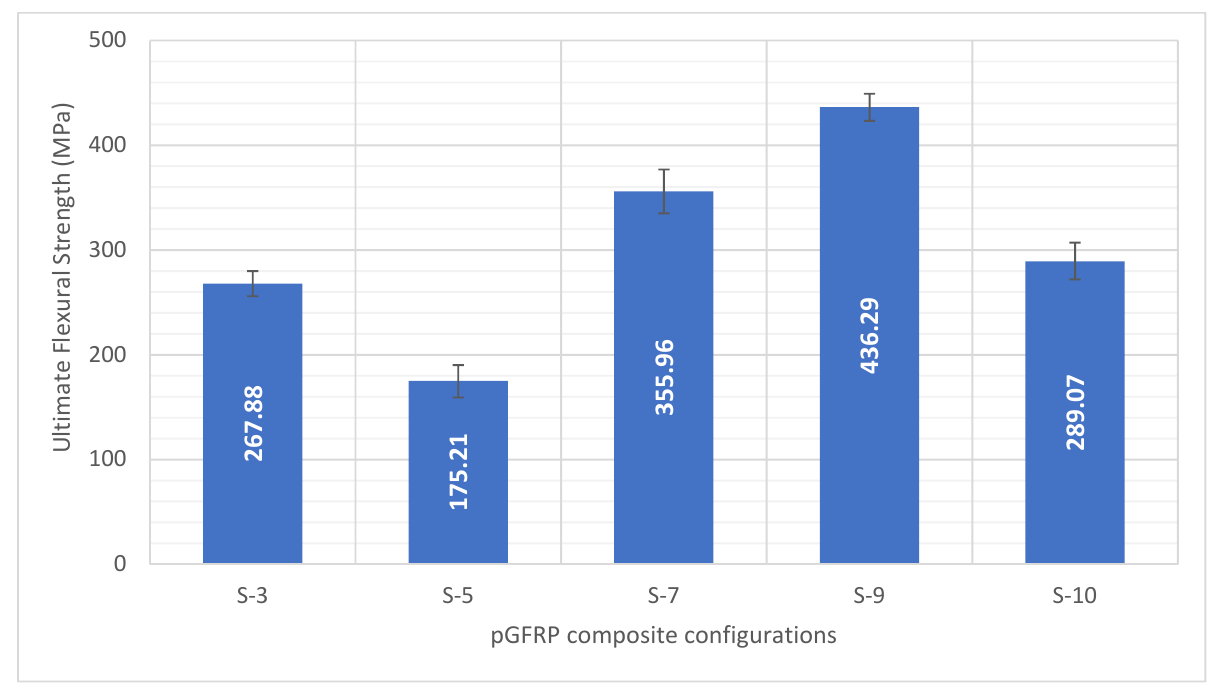
Figure 5. Ultimate flexural strength of pGRRP composites with various stacking sequences.